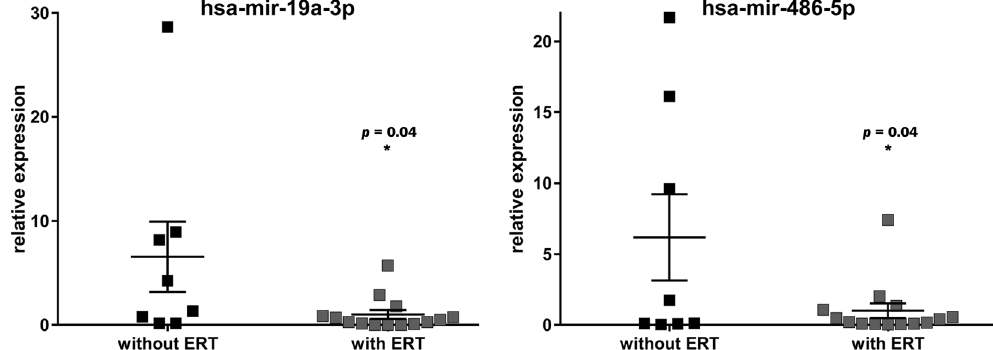
Figure 4. Validation of miRNA candidates in serum of male Fabry patients. Illustration of the relative expression of miRNA candidates validated in serum samples of male Fabry patients by RT-qPCR. * p < 0.05.